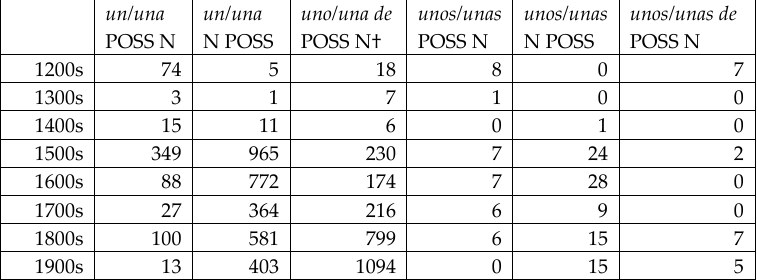
Table 12. Algún , etc. + POSS + N in CdE (raw occurrences).